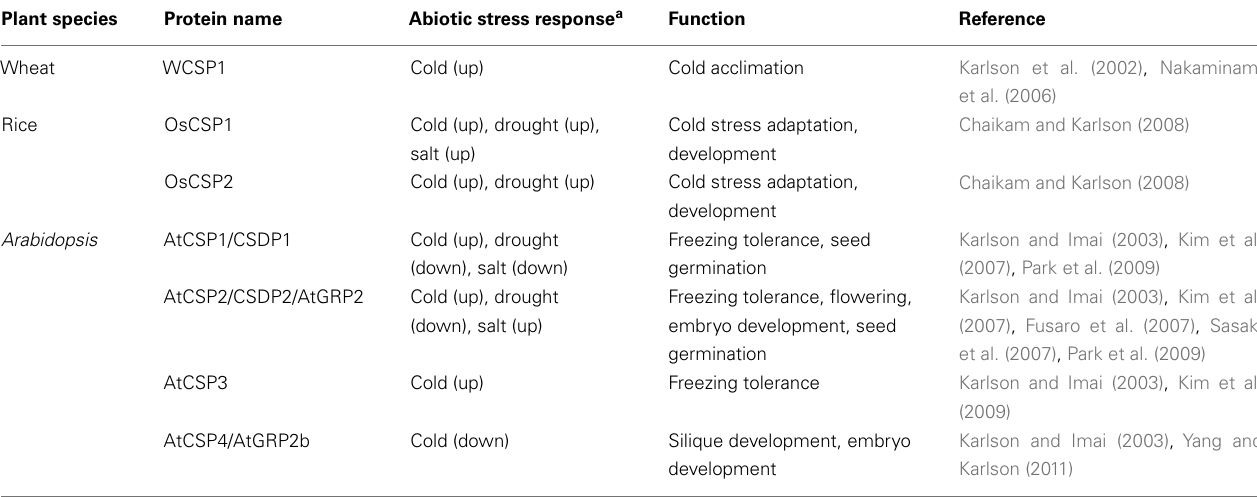
Table 1 | Characterized plant cold shock domain